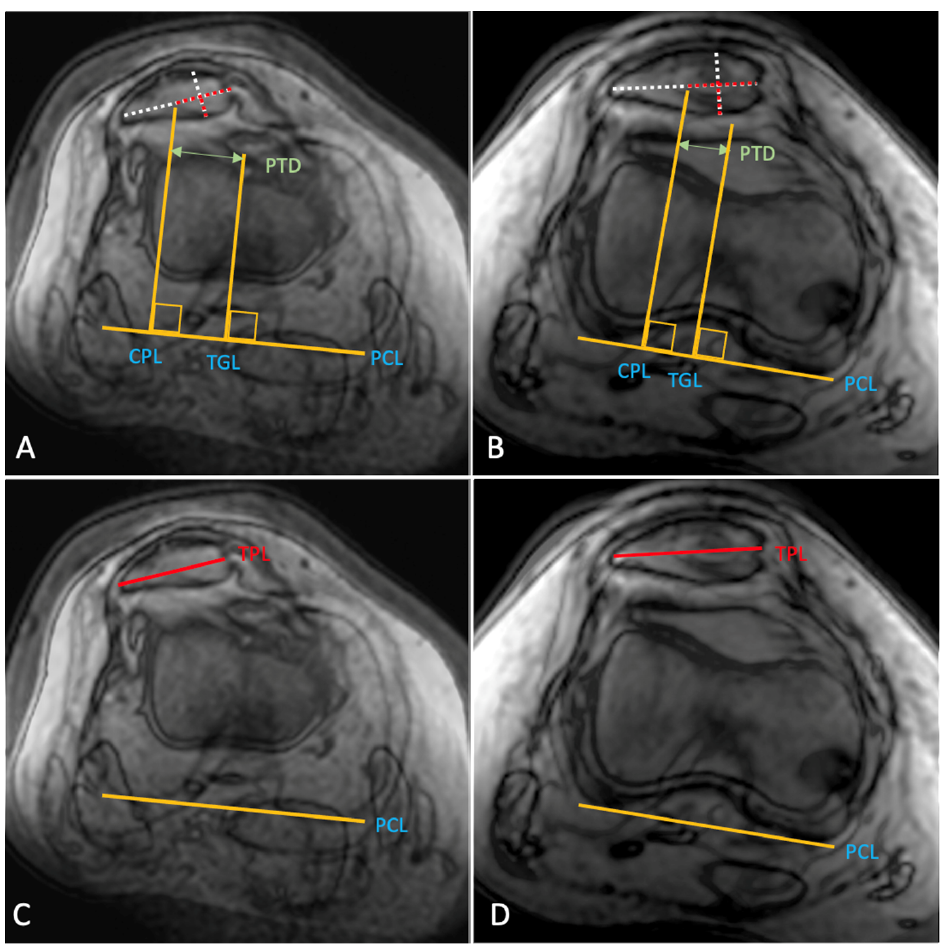
Figure 6. Preoperative and postoperative measurement of the proximal patella position in a fully extended right knee. Compared to the preoperative examination ( A ), the postoperative patellotrochlear distance (PTD) ( B ), measured between the deepest point of the trochlea groove (TGL) and the center-center position of the patella (CPL), was significantly reduced. Accordingly, the postoperative patellar tilt (angle between the transpatellar line [TPL] and the posterior condylar line [PCL]) was reduced significantly compared to the preoperative value ( C , D ). All measurements were performed on transversely oriented MRI slides, in accordance with the technique described by Frings et al. [23] .